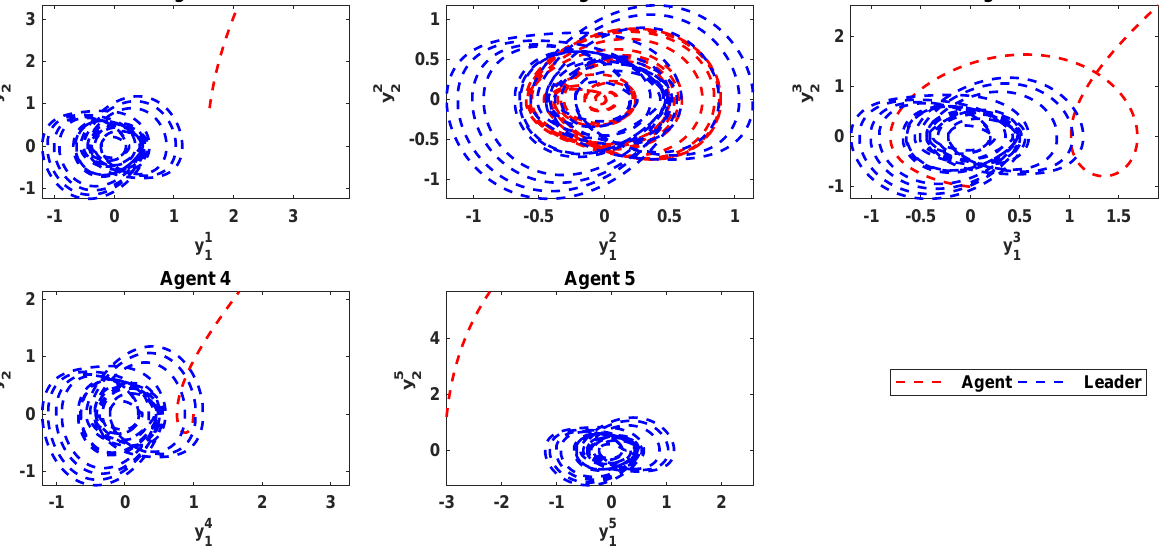
Figure 13. Example 2: Control signals.